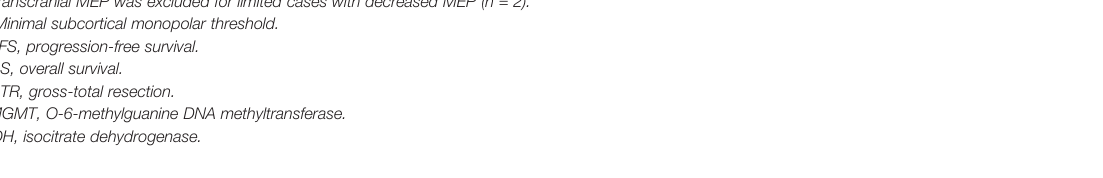
TABLE 3 | Independent factors to predict postoperative motor de fi cit (Logistic regression, n = 79) and prognoses (Cox regression, n = 42). Independent factors to predict OR (95% CI) Motor de fi cit on day 1 after